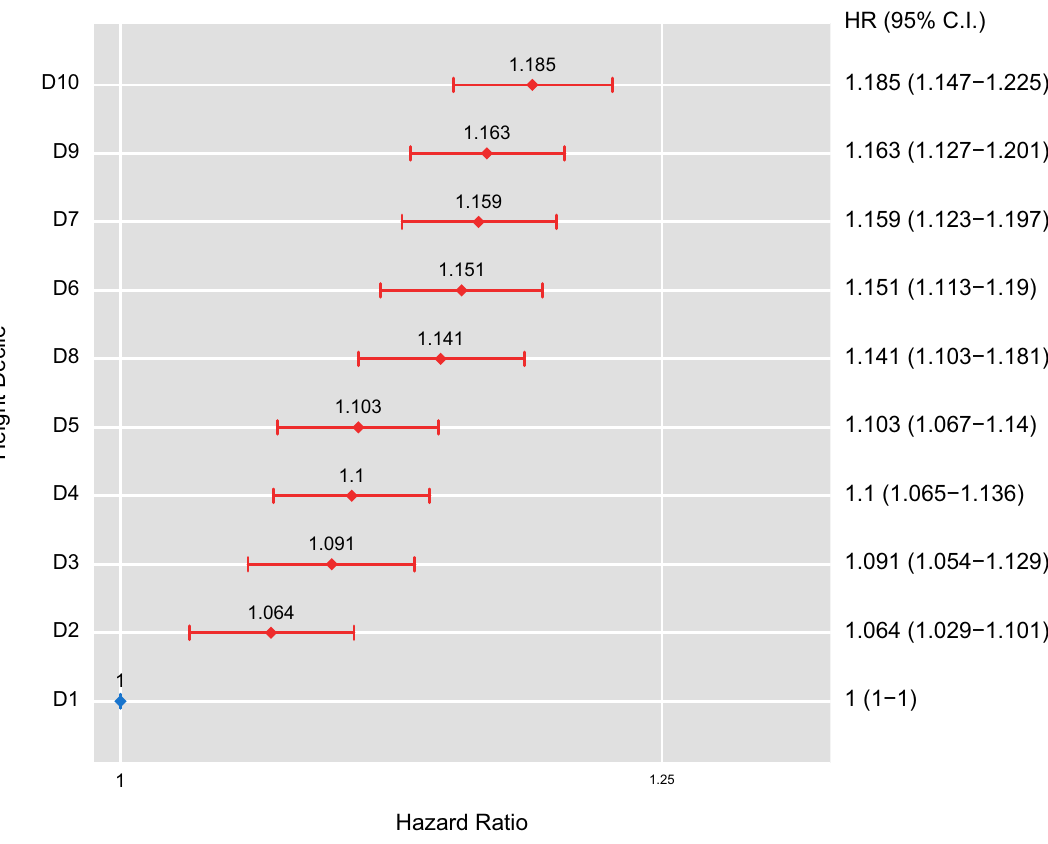
Figure 2. Hazard ratios (HRs) for anosmia by height decile after adjustment for age, sex, BMI, income, smoking status, alcohol consumption, regular physical activity, hypertension, diabetes mellitus, dyslipidemia. The Y-axes show deciles of height, while the X-axes show hazard ratios with reference to the 1st decile for height. Diamonds represent HRs, and horizontal lines indicate 95% confidence